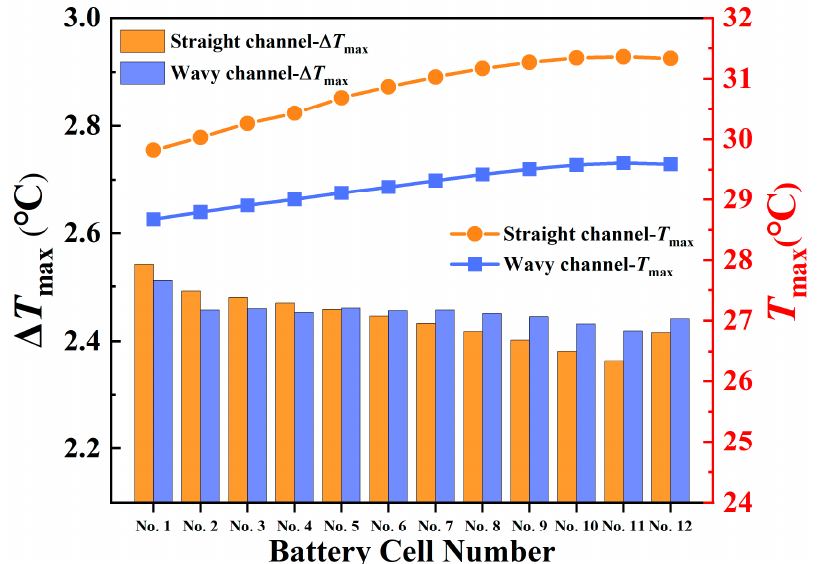
Figure 7. The maximum temperature difference ( △ T max ) and maximum temperature ( T max ) of each battery.